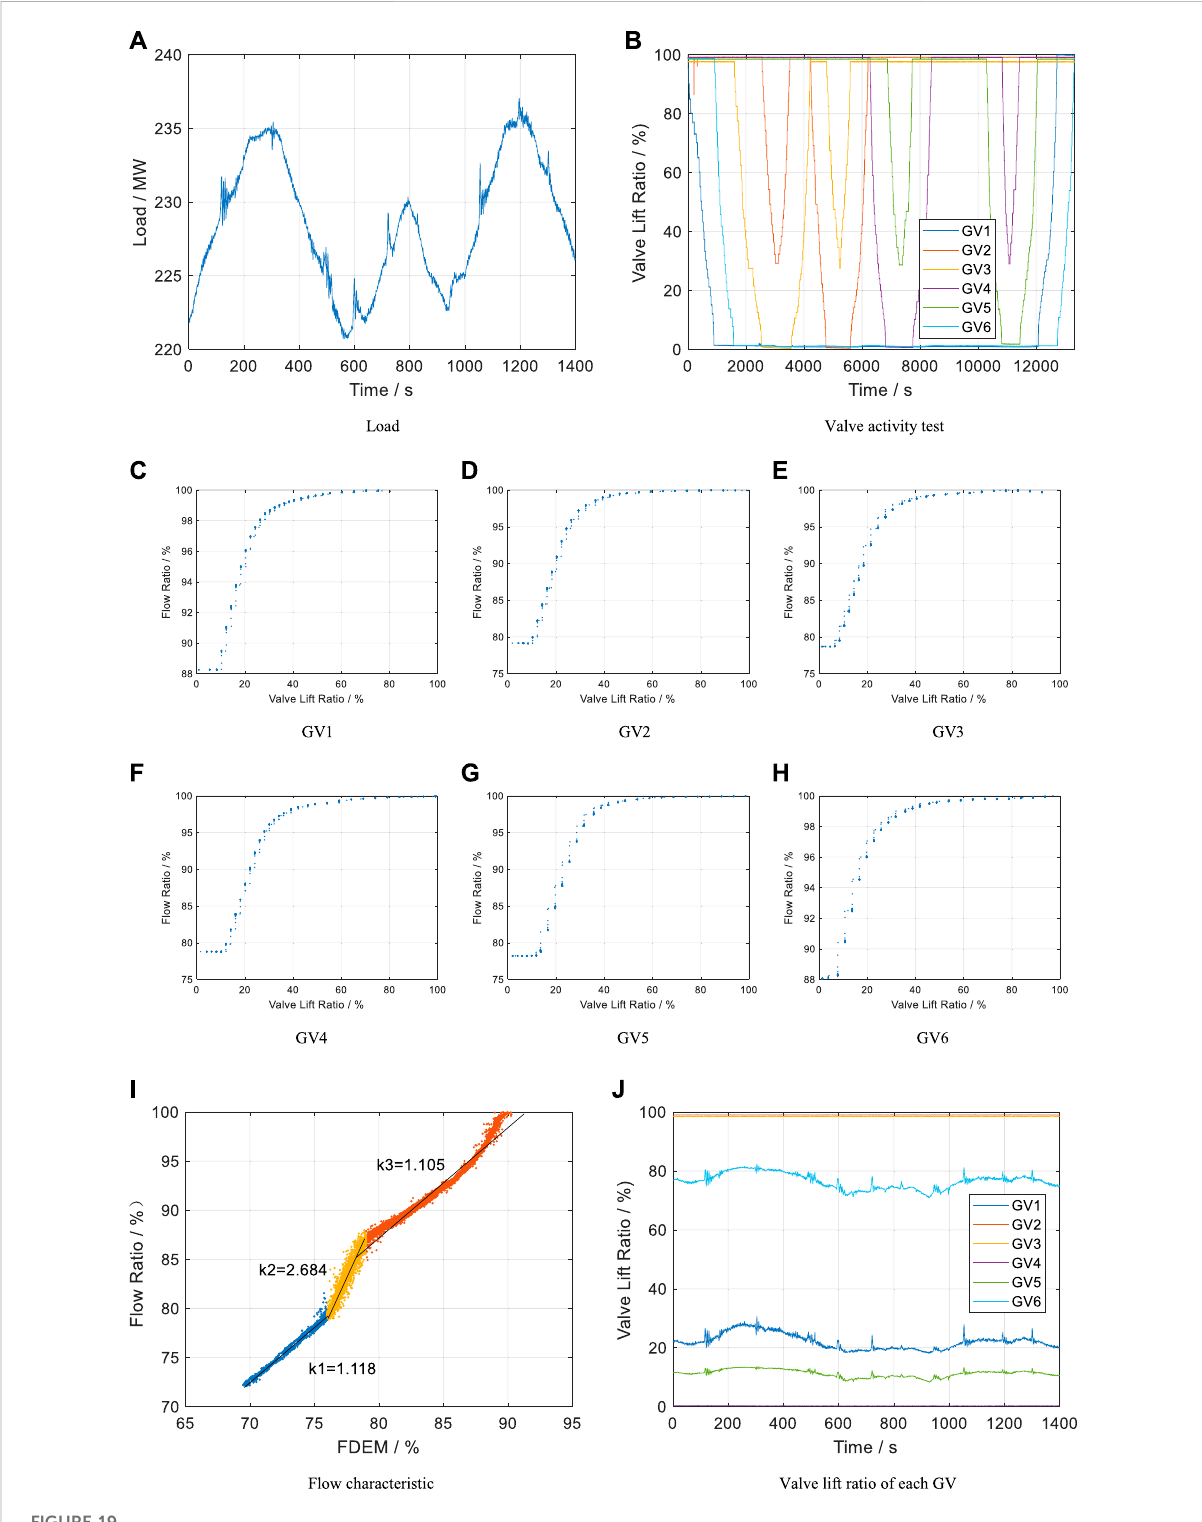
FIGURE 19 6 GVs activity test. (A) Load. (B) Valve activity test. (C) GV1. (D) GV2. (E) GV3. (F) GV4. (G) GV5. (H) GV6. (I) Flow characteristics. (J) Valve lift ratio for each